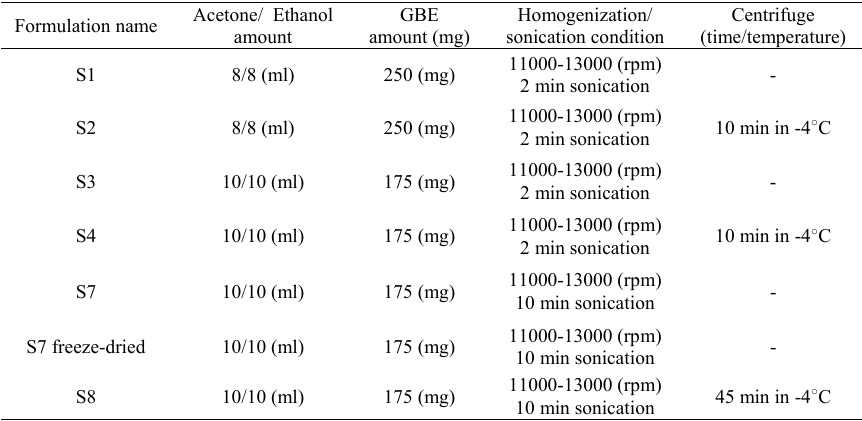
Table1: Preparation of GBE-SLNS with different experimental conditions. Table 1. Preparation of GBE-SLNS with different experimental